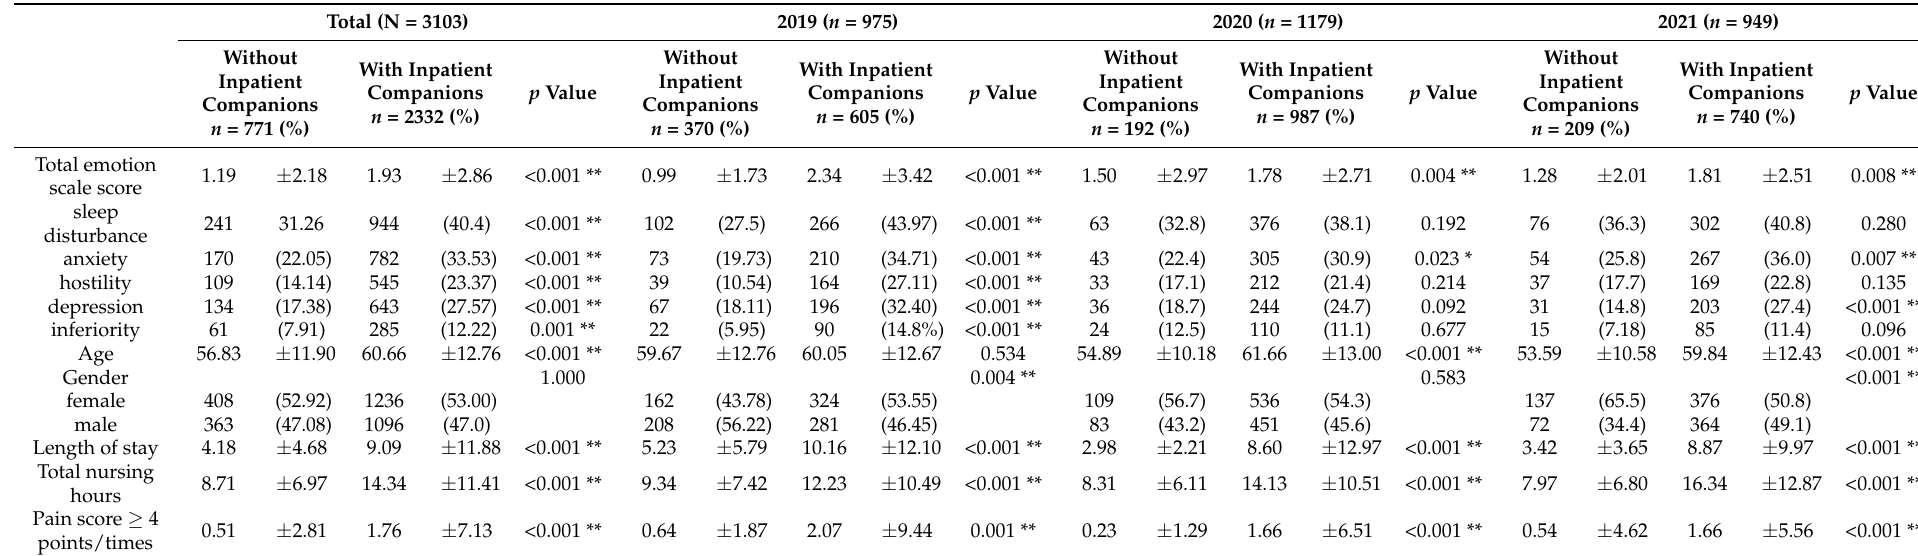
Table 3. Differences between cancer inpatients with and without inpatient